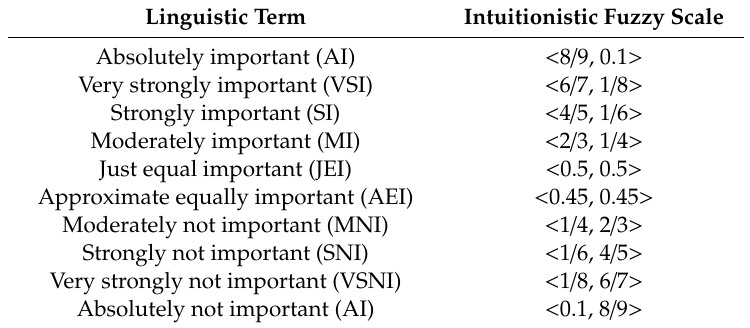
Table 1. Linguistic scales and intuitionistic fuzzy scales for comparing the importance of